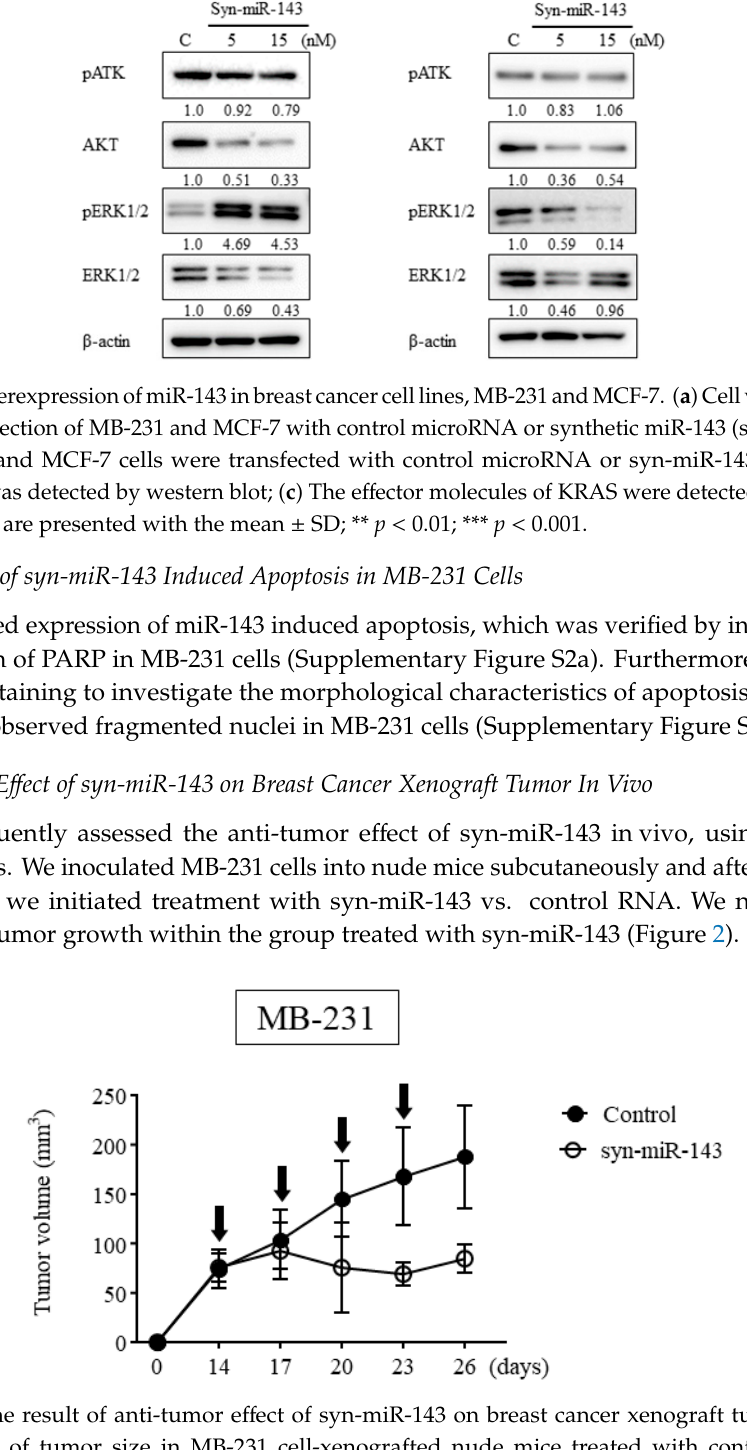
Figure 2. The result of anti-tumor effect of syn-miR-143 on breast cancer xenograft tumor in vivo. Time course of tumor size in MB-231 cell-xenografted nude mice treated with control RNA or syn-miR-143. Arrow represents a treatment with control RNA (1.5 mg/kg/administration) or syn-miR-143 (1.5 mg/kg/administration) given every 3 days. Syn-miR-143, synthetic miR-143.